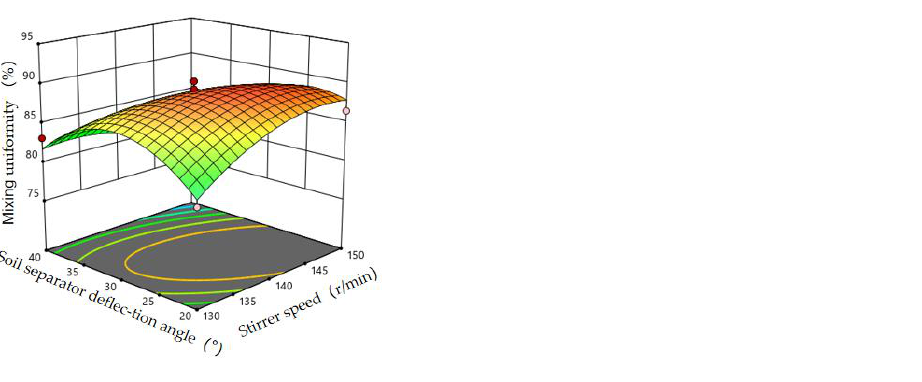
Figure 12. Influence of the interaction terms of Stirrer speed and soil separator deflection angle on the mixing uniformity.